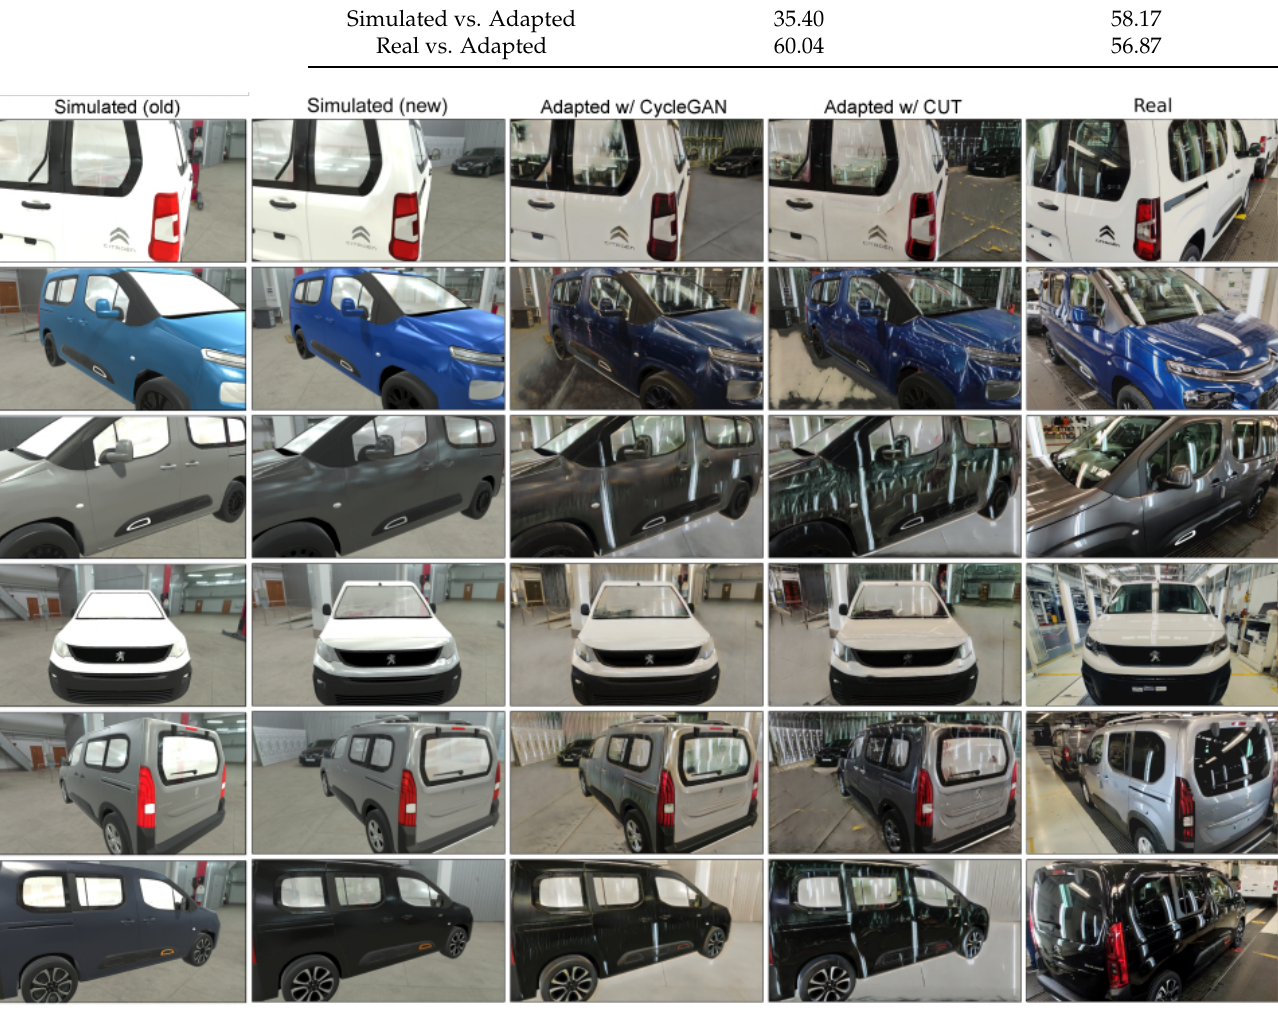
Figure 6. Examples of domain adapted images with CycleGAN and CUT, and their comparison to real images collected on the factory floor. We also include a comparison between the old and new versions of the simulated datasets on the first two